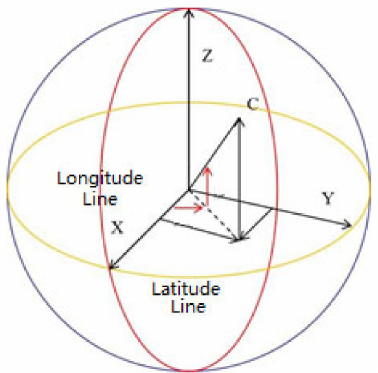
Figure 7. Spherical definition diagram of latitude and